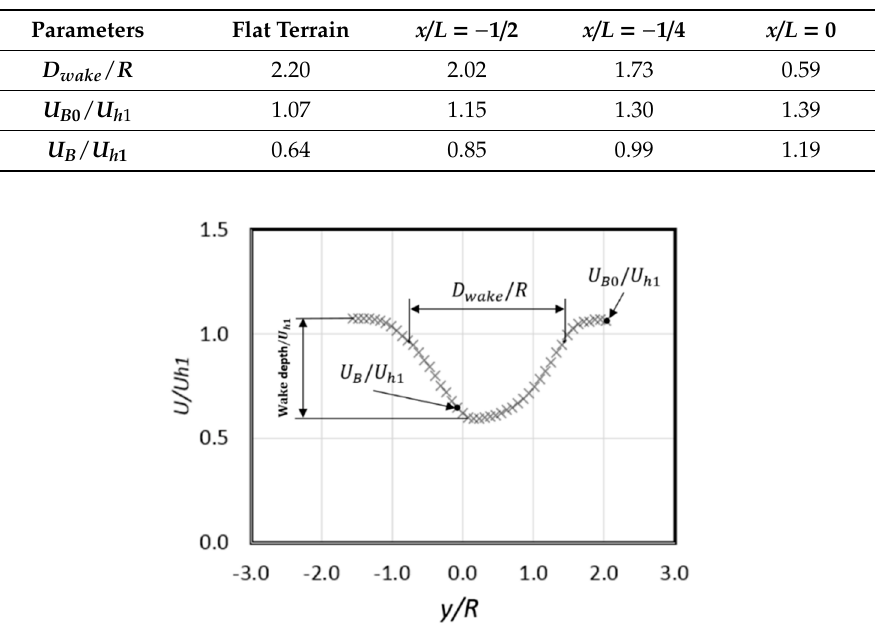
Figure 13. Wake over flat terrain at 6.09 D (Wind turbine at x = − L , measurement at x = L ).